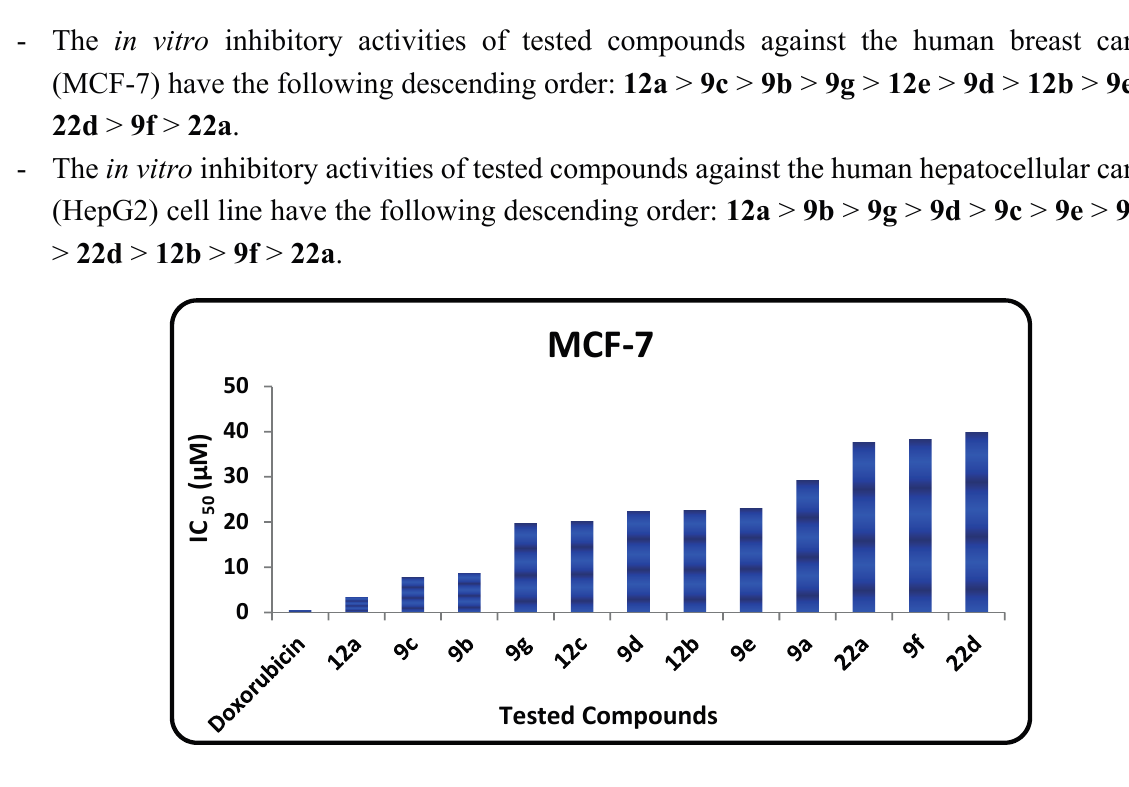
Figure 2. IC 50 values of tested compounds against MCF-7.